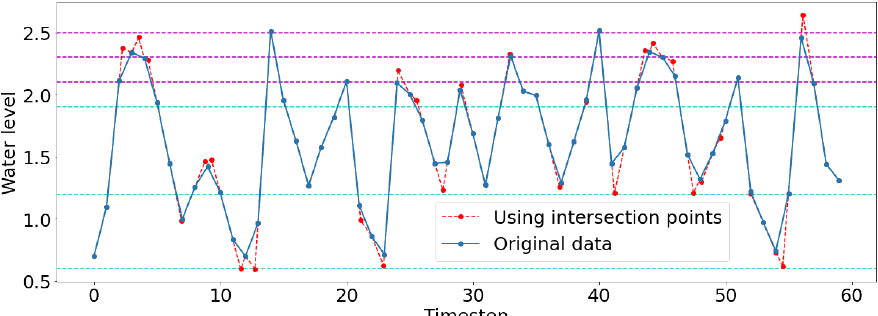
Figure 9. The water level using the readings and the existing intersection points ( x I ( n ) , f ( x I ( n ))) for a sample of the data set.